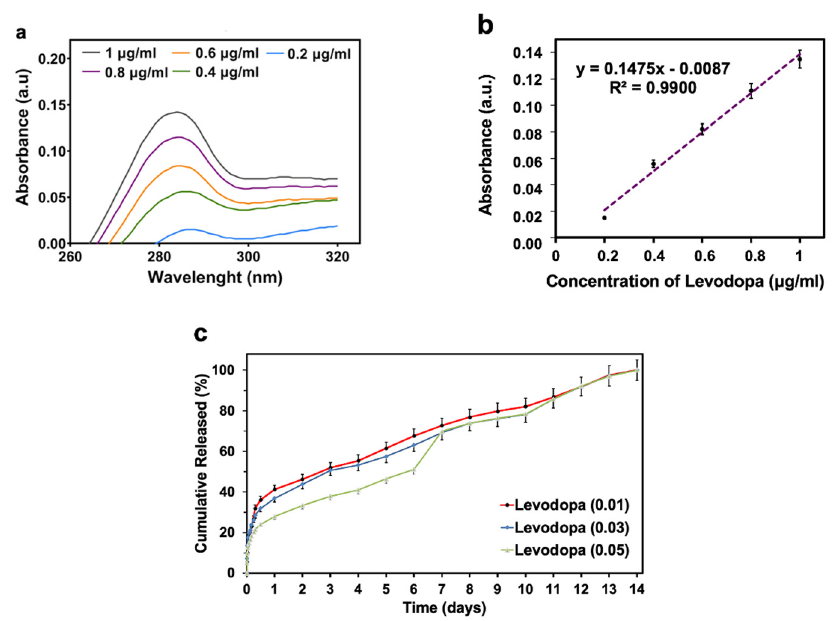
Figure 5. In vitro drug release profiles of levodopa from the 3D-printed scaffolds: Absorption spectra of levodopa at different concentrations ( a ), levodopa calibration curve ( b ), levodopa release profiles from the scaffolds that have the concentration of levodopa at 0.01 mg/mL, 0.03 mg/mL, and 0.05 mg/mL ( c ). All the measurements were repeated three times and the errors were less than 5%.